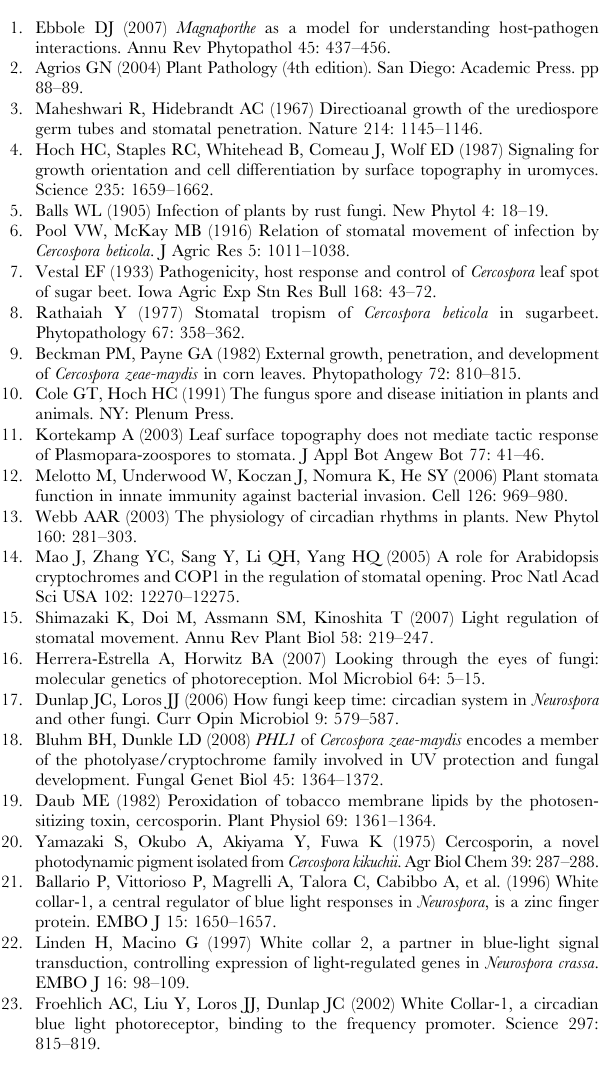
Figure S1 Effect of blue light on cercosporin biosynthesis of Cercospora spp. Pictures were taken four days after inoculation on 0.2 6 PDA. Figure S2 Disruption of CRP1 . A, Disruption of CRP1 was accomplished by inserting a hygromycin-resistance cassette (HYG R ) into the open reading frame of the gene via homologous recombination. B, Identification of strains disrupted in CRP1 ( D crp1 ) by PCR. A size standard (1 kb DNA ladder; Invitrogen) represented by M. Two transformants were identified with primer sets A1/H3 and A2/H5 as disrupted in CRP1 Insertion of the HYG R cassette into CRP1 .